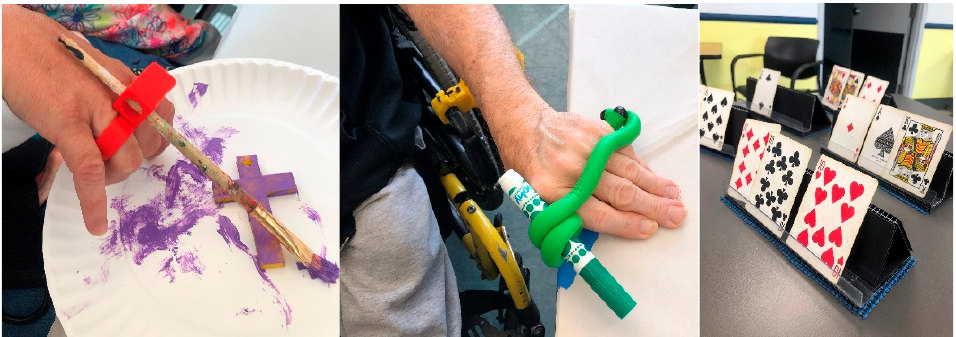
Figure 3. AT prototypes built for